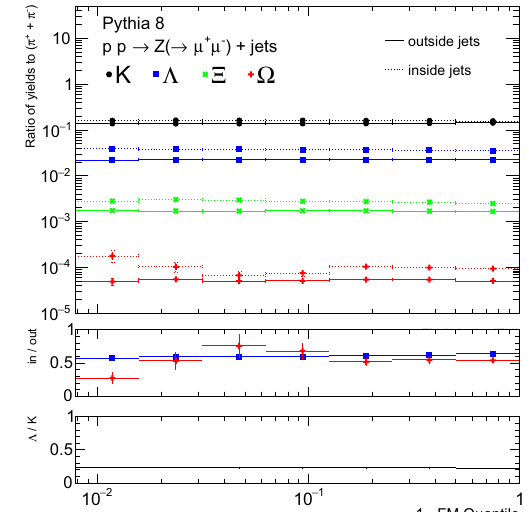
below the median FM. The left plot shows the trends without the Rope hadronization model while the right plot has the Rope model enabled